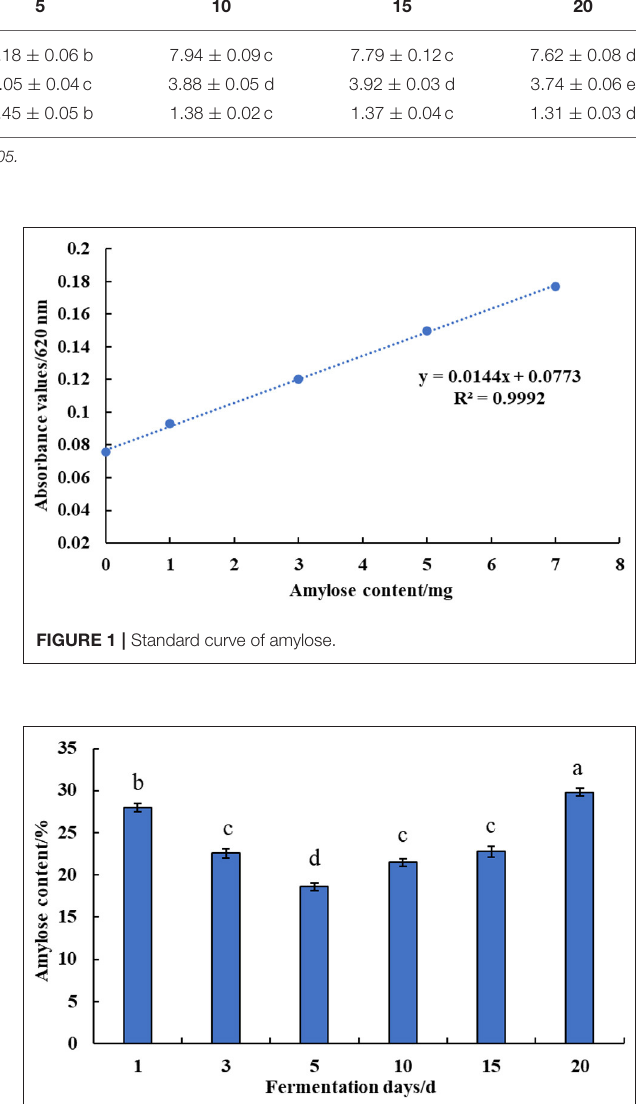
TABLE 1 | Effects of natural fermentation on the content of chemical constituents of corn ballast. Fermentation time/d